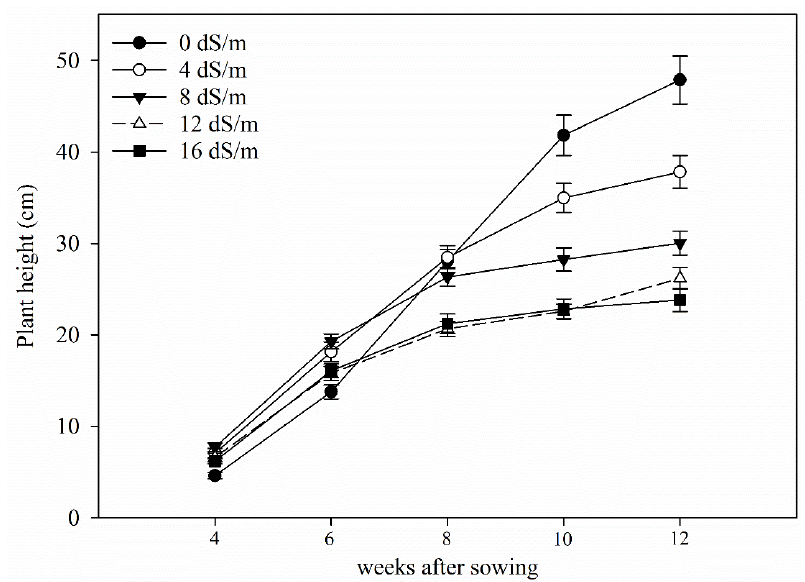
Figure 2. Average plant height (cm) of alfalfa plants at different stages of growth under five gradients of salinity (Electrical conductivities of 0 dS m −1 , 4 dS m −1 , 8 dS m −1 , 12 dS m −1 , 16 dS m −1 ) (salt stress was applied on 4 weeks old plant; error bar represents standard errors of means).